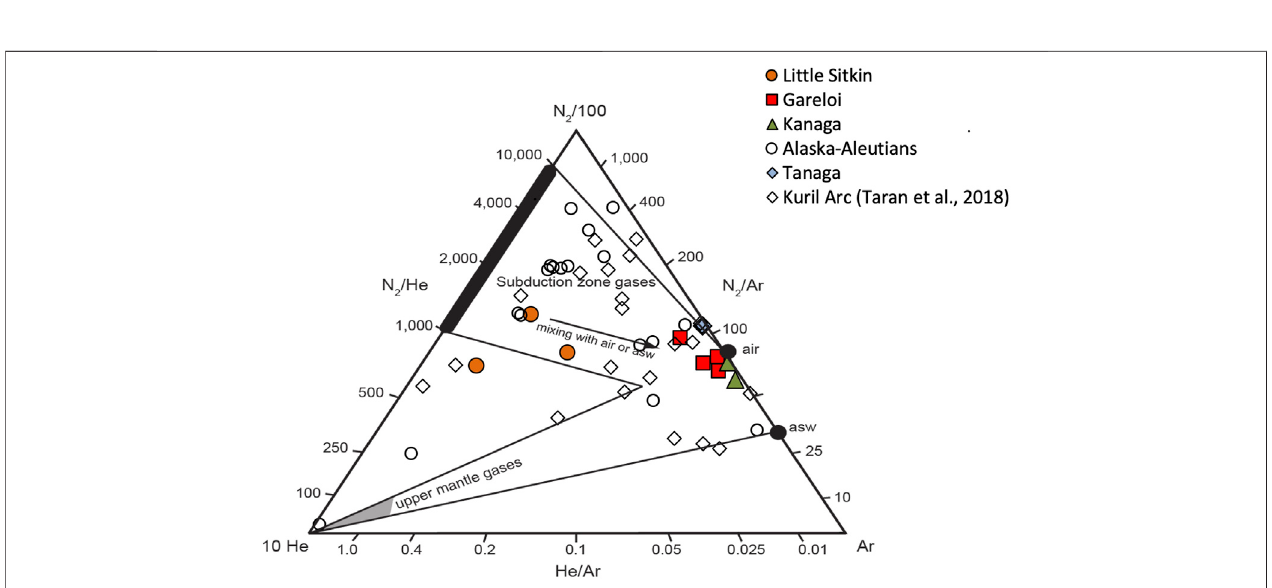
Frontiers in Earth Science |